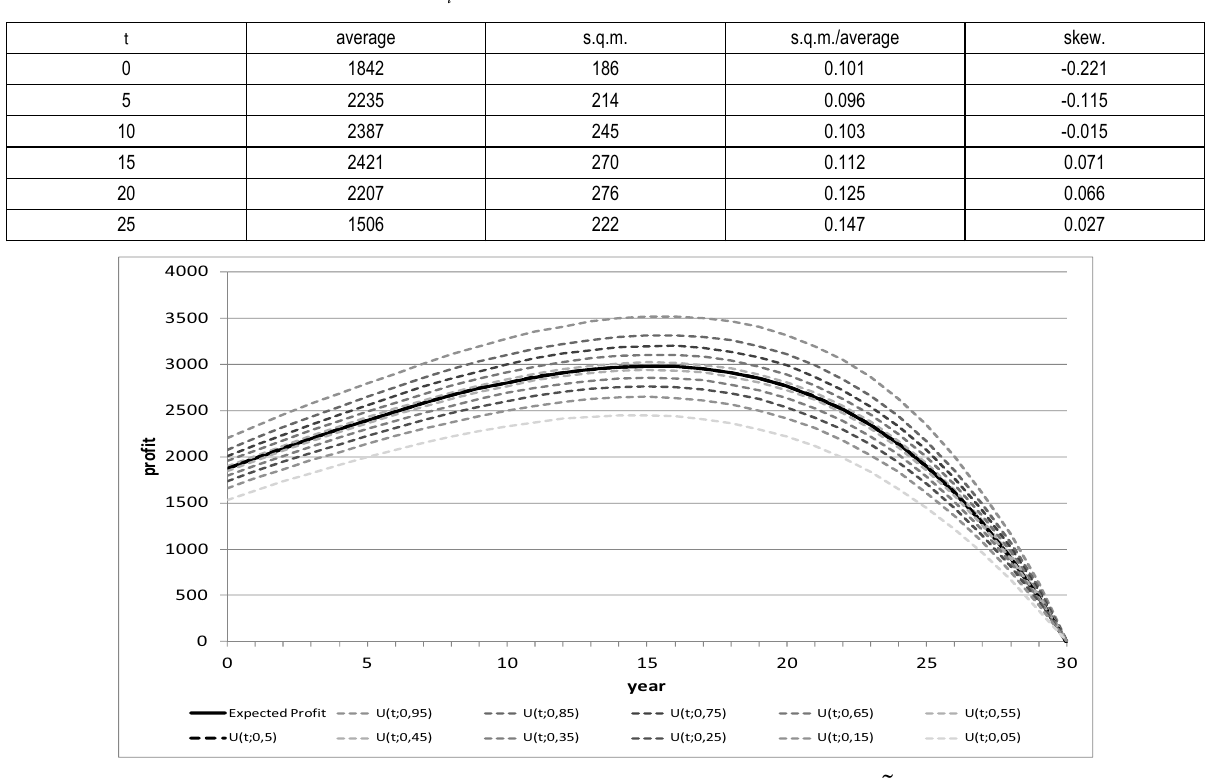
(cid:5) U evidenced for the standard stochasticity level, with contract escapes t